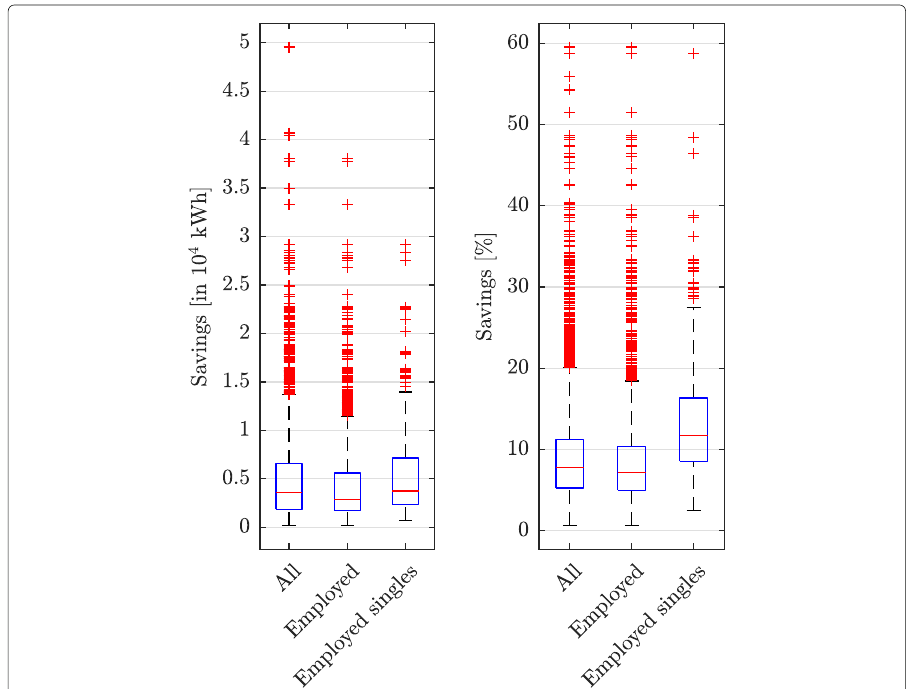
Fig. 4 The absolute savings in kWh and relative savings in % for each group for the oracle strategy over the period of 75 weeks